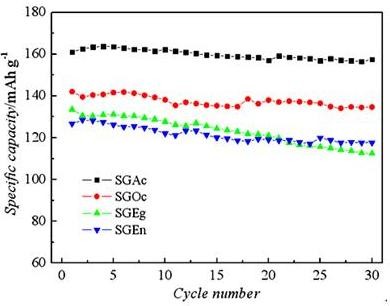
Cycle life of LiFePO4/C.